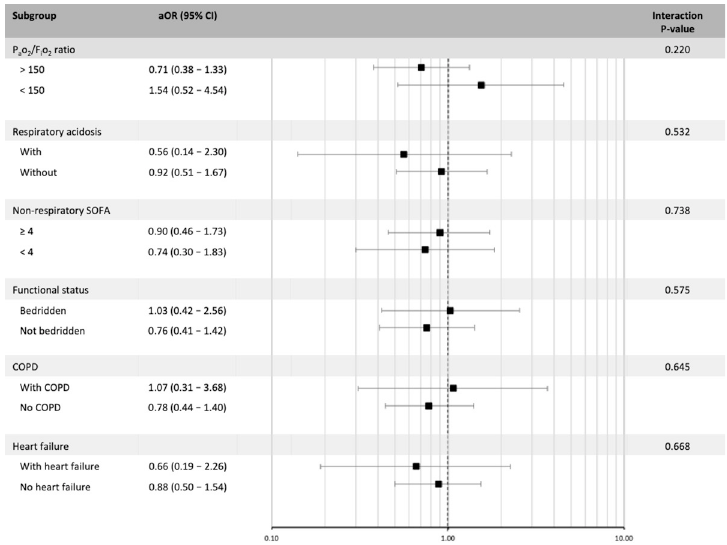
Fig 2. Subgroup analysis of the effect of noninvasive ventilation vs. invasive mechanical ventilation on hospital mortality. The x-axis represents the odds ratio for the comparison of noninvasive ventilation (NIV) vs. invasive mechanical ventilation (IMV) according to the analyzed subgroup. SOFA: Sequential organ failure assessment; COPD: Chronic obstructive pulmonary disease.